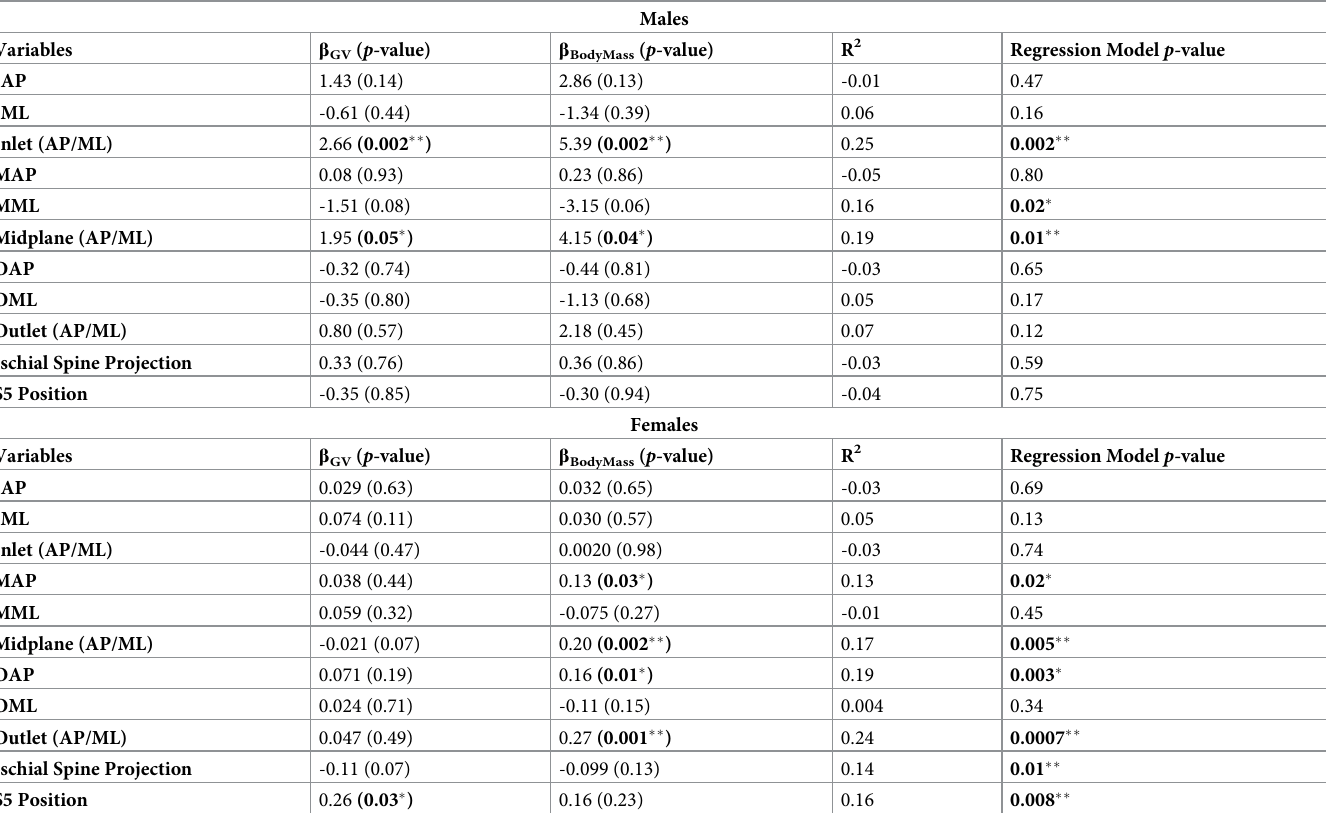
Table 4. Summary of regression results.